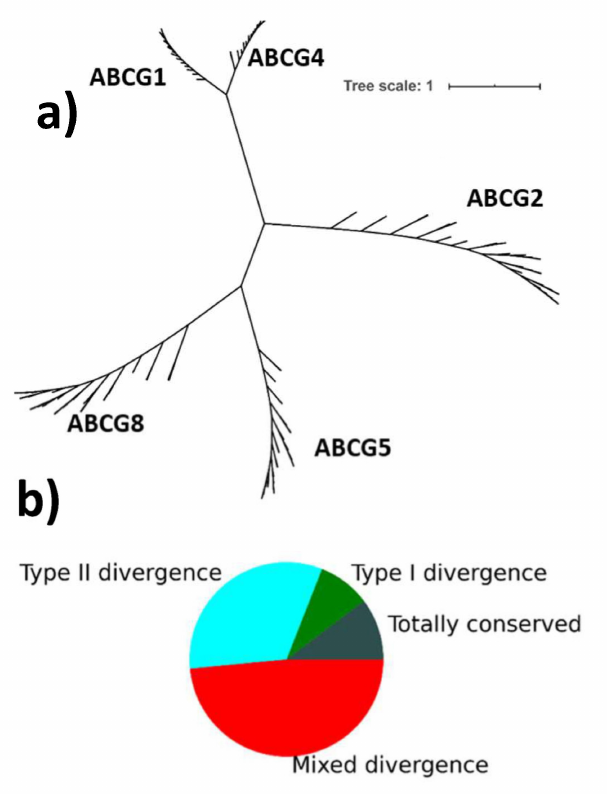
Figure 1. ( a ) Phylogenetic tree of mammalian ABC subfamily G proteins. Tree based on 174 protein sequences, aligned with multiple alignment fast Fourier transform (MAFFT). Names of taxa have been removed for clarity. ( b ) Pie chart showing proportions of conservation and divergence. In the 594 columns showing conservation in at least one protein in the G subfamily, 61 are totally conserved (grey); 52 show simple type I divergence (where one set has conservation, and the others do not) (green); 193 show type II divergence (where each set is conserved, but with a different residue) (cyan); and the remaining 288 have some mixture of divergence (e.g., column 891 is a conserved cysteine in ABCG2, and a conserved leucine in ABCG1 and ABCG4, but is not conserved in other groups. Thus it has neither purely type I nor type II divergence)